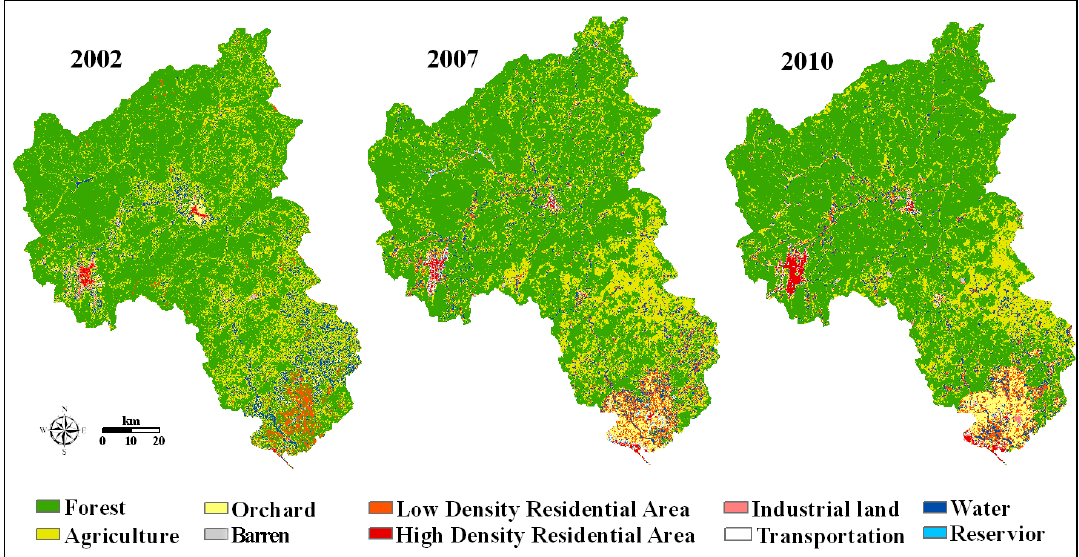
Figure 3. Land use maps in 2002, 2007 and 2010 in the North River Watershed.